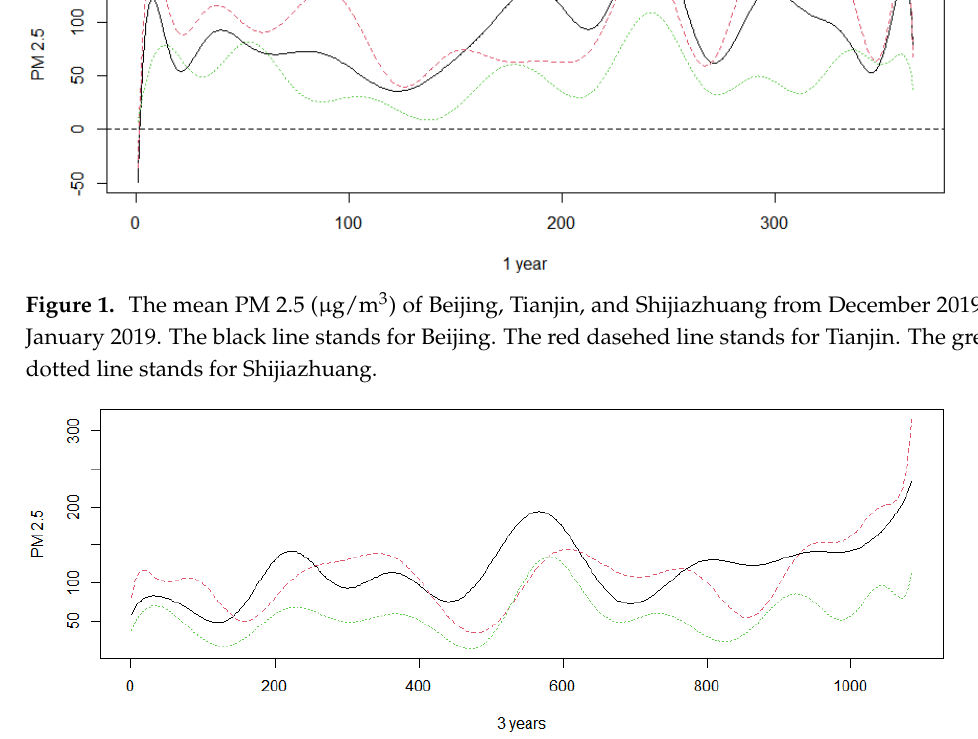
Figure 2. The mean PM 2.5 ( µ g/m 3 ) of Beijing, Tianjin, and Shijiazhuang from December 2019 to January 2017. The black line stands for Beijing. The red asehed line stands for Tianjin. The green dotted line stands for